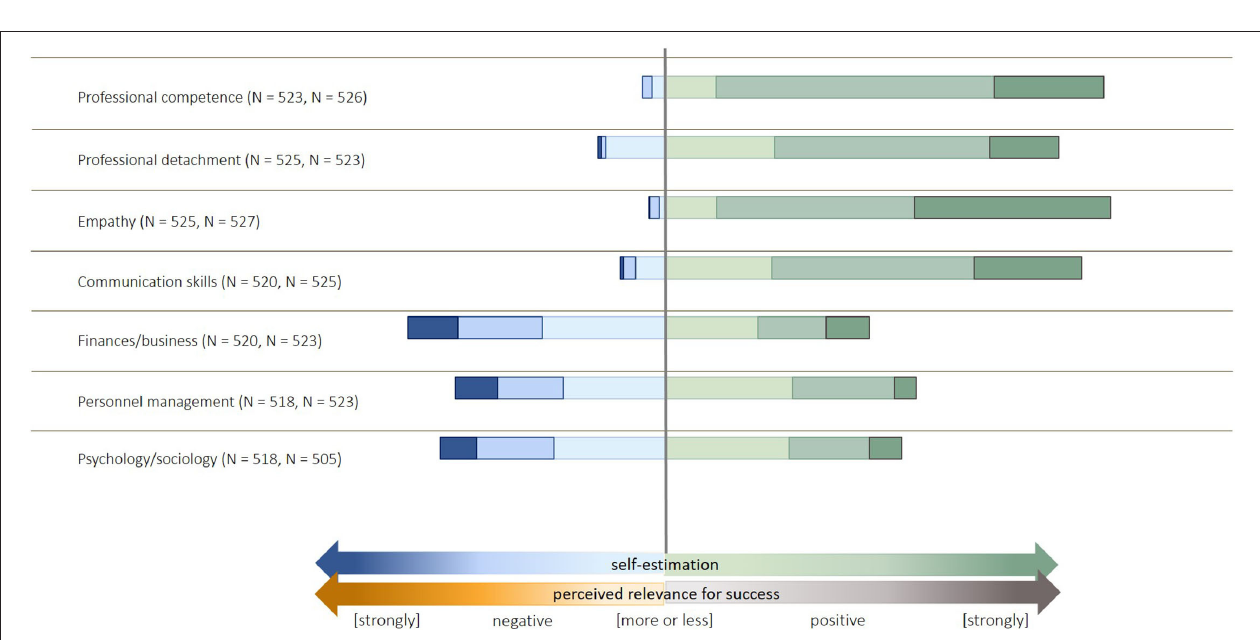
FIGURE 1 | Description of the items used to build the latent factor “shared decision making” in the survey. The items were identified by an exploratory factor analysis and structural equation modeling, as described in Küper and Merle ( 11).